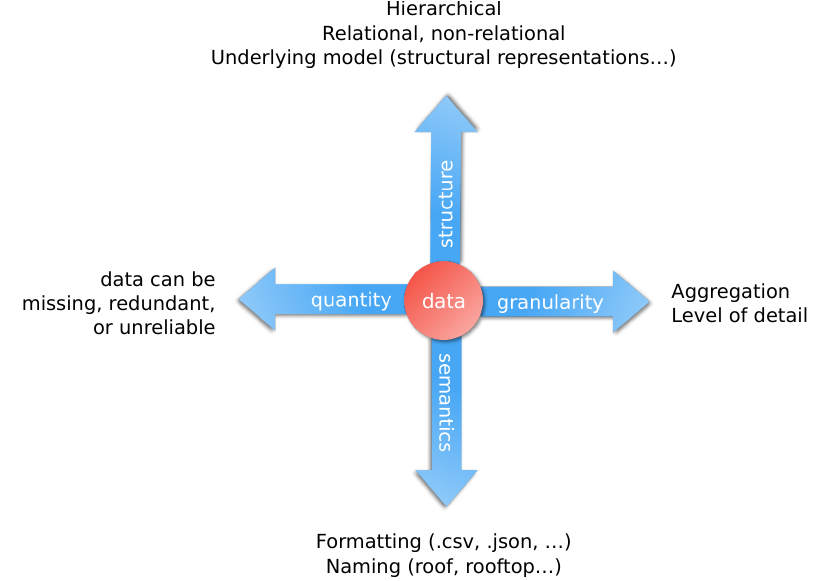
Figure 3. Data heterogeneity in